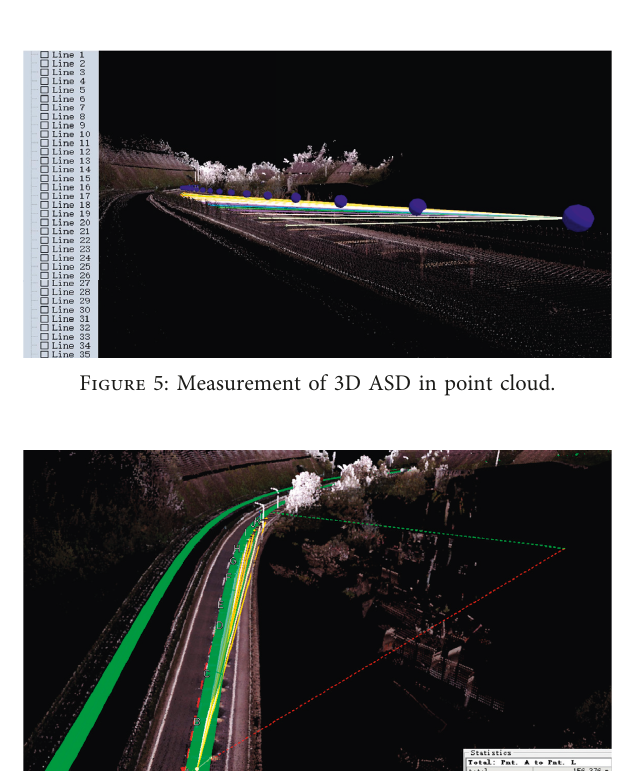
Figure 4: Extraction of cross sections from point cloud.